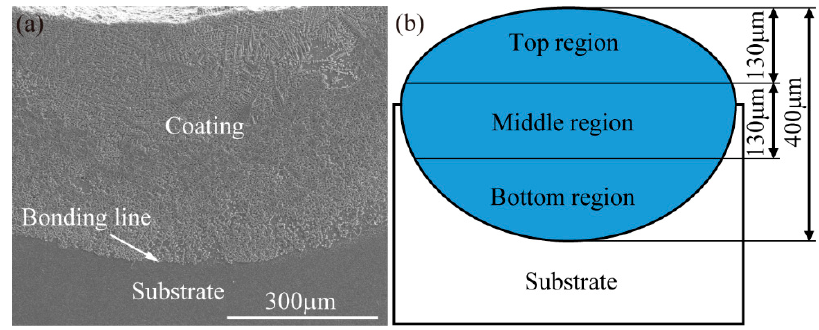
Figure 4. ( a ) Typical macrostructure of the coating; ( b ) 3 regions of the coating.